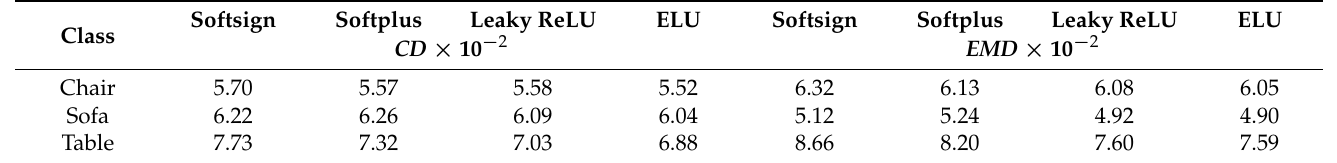
Table 5. Reconstruction results of different activation functions on Pix3D dataset. Table 6. Reconstruction results on Pix3D evaluated by CD.